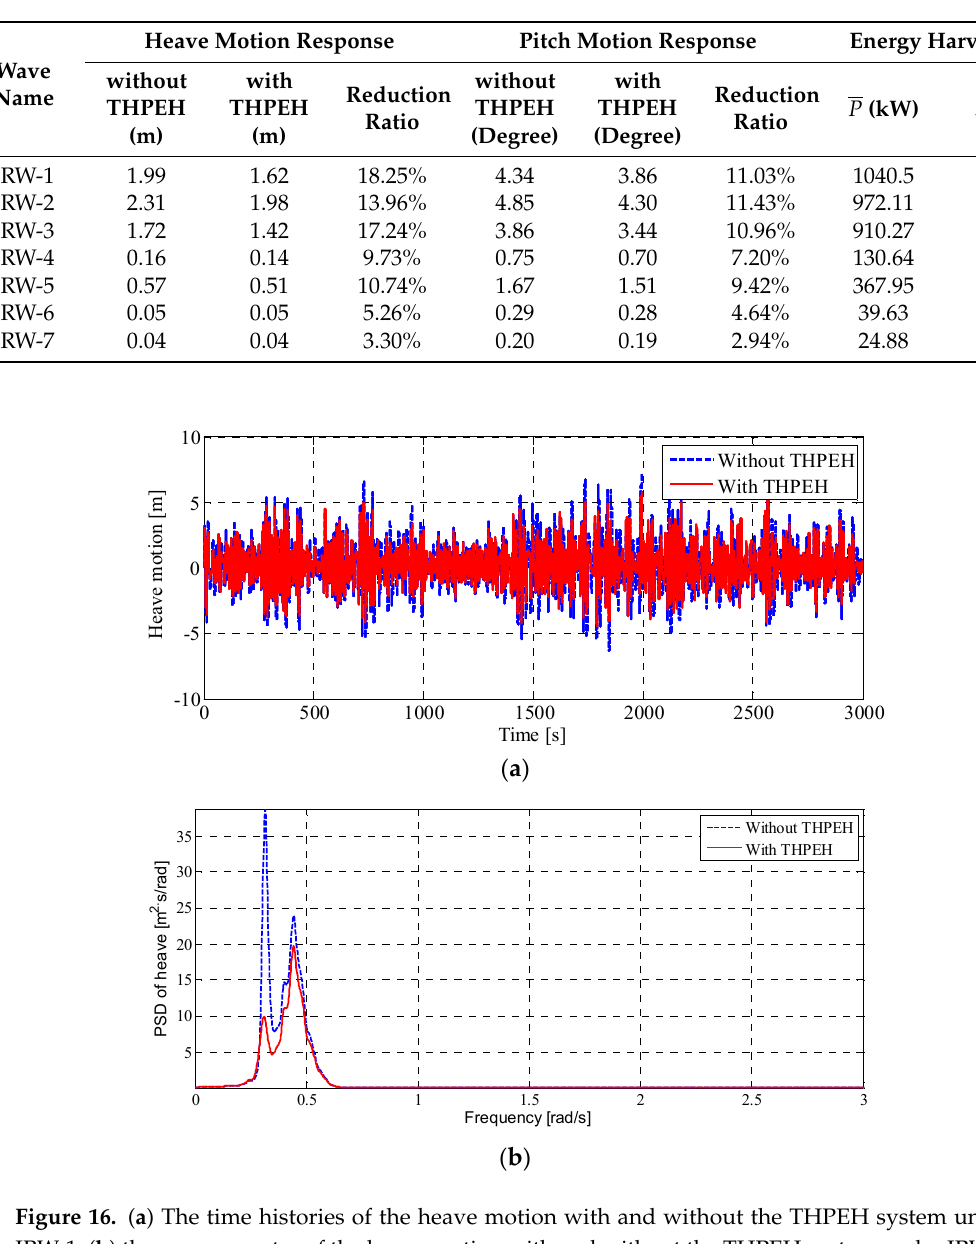
(b) The power spectra of the pitch motions Figure 17. ( a ) The time histories of the pitch motion with and without the THPEH system under IRW ‐ 1; ( b ) the power spectra of the pitch motion with and without the THPEH system under IRW ‐ 1.